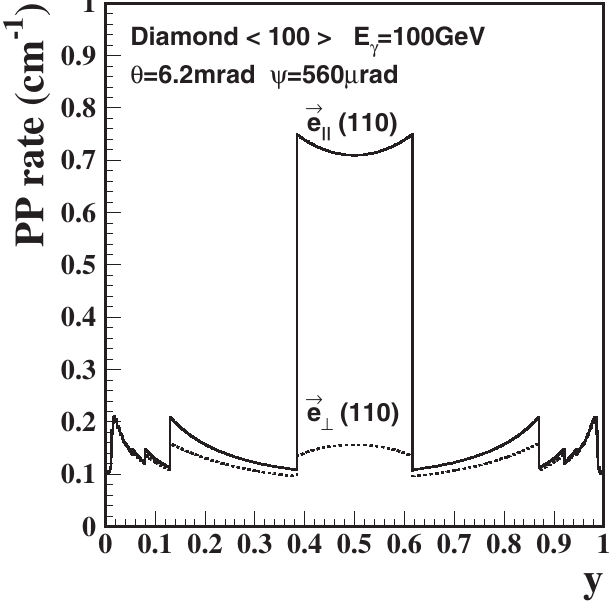
FIG. 4. Pair production rate vs the pair asymmetry, y , as defined in the